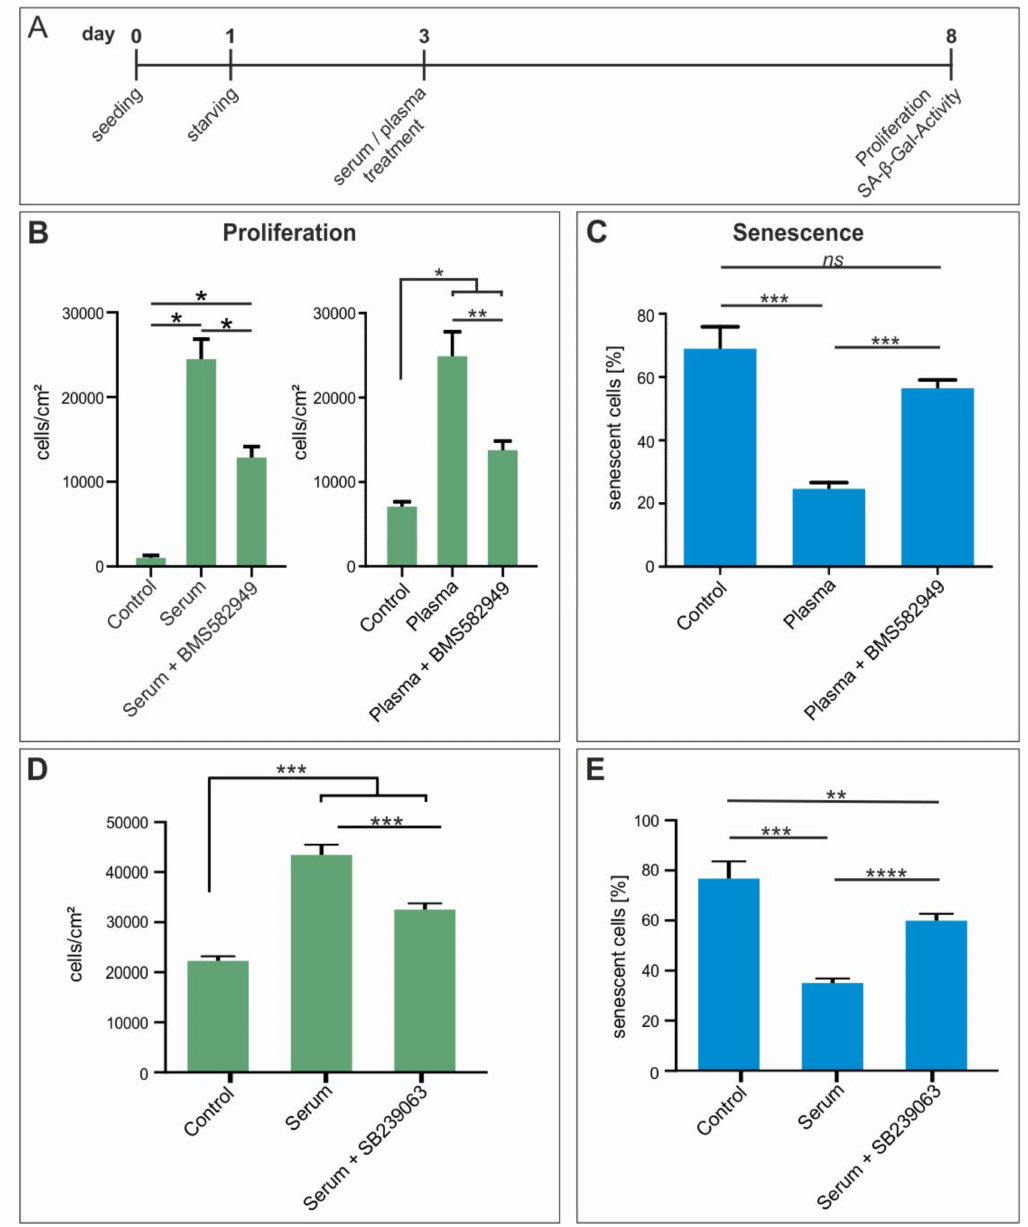
Figure 7. In vitro inhibition of p38-MAPK reversed the beneficial e ff ect of blood plasma on proliferation and survival of hCSCs. ( A ) hCSCs where exposed to blood plasma and serum and p38 inhibitors BMS-582949 and SB239063. ( B ) Inhibition of p38 with BMS582949 led to significantly decreased proliferation compared to plasma and serum treatment alone. ( C ) Inhibition of p38 with BMS582949 led to significantly elevated SA- β -Gal activity compared to plasma treatment alone. ( D ) Inhibition of p38 with SB239063 led to significantly decreased proliferation compared to serum treatment alone. ( E ) Inhibition of p38 with SB239063 led to significantly elevated SA- β -Gal activity compared to serum treatment alone. Mann-Whitney two-tailed, * p < 0.05; ** p < 0.005; *** p < 0.0005; **** p < 0.0001 was considered significant, not significant (n.s.) p >